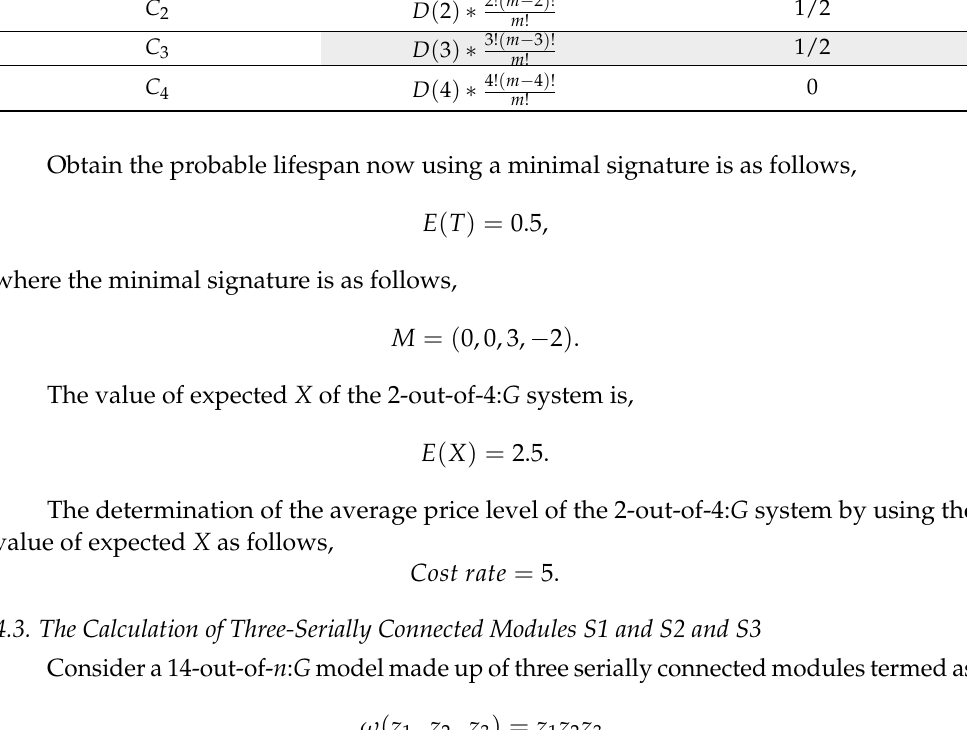
Table 6. The cumulative signature of the 2-out-of-4: G system. Components Cumulating Formula Cumulating Value